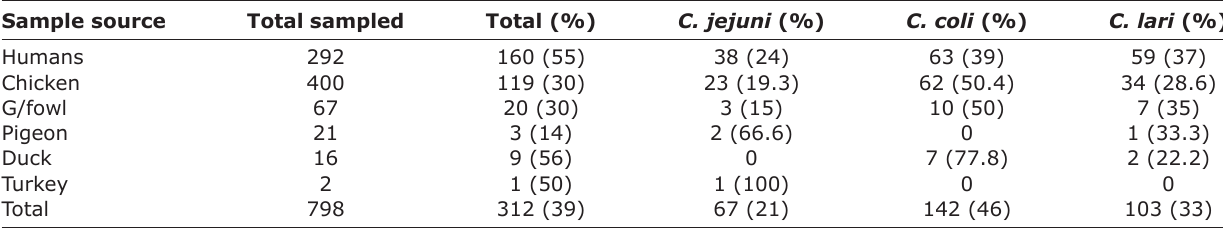
Table-1: Prevalence of Campylobacter species in different species of poultry and humans in Sokoto State. Sample